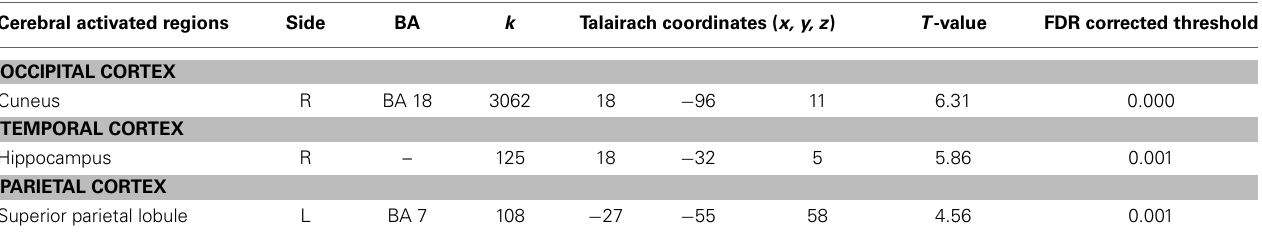
Table 2 | Activated regions for spatial encoding commonly activated for A, EU, ERO, vs. C (Conjunction analysis, statistical threshold: uncorrected p < 0 . 001, cluster extent: k ≥ 10 voxels).